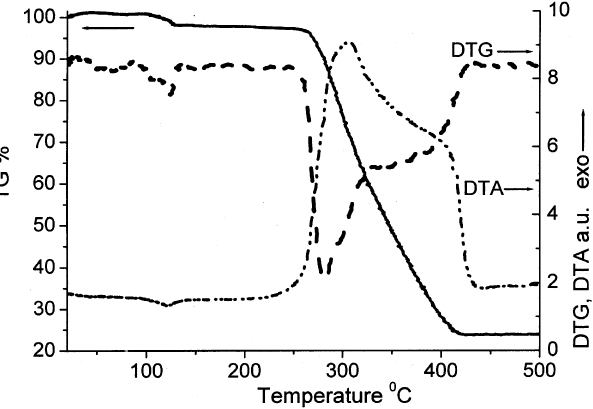
Figure 5. TG, DTG and DTA curves for the sample [ Cu 2 (EDPB)•H 2 O] n .